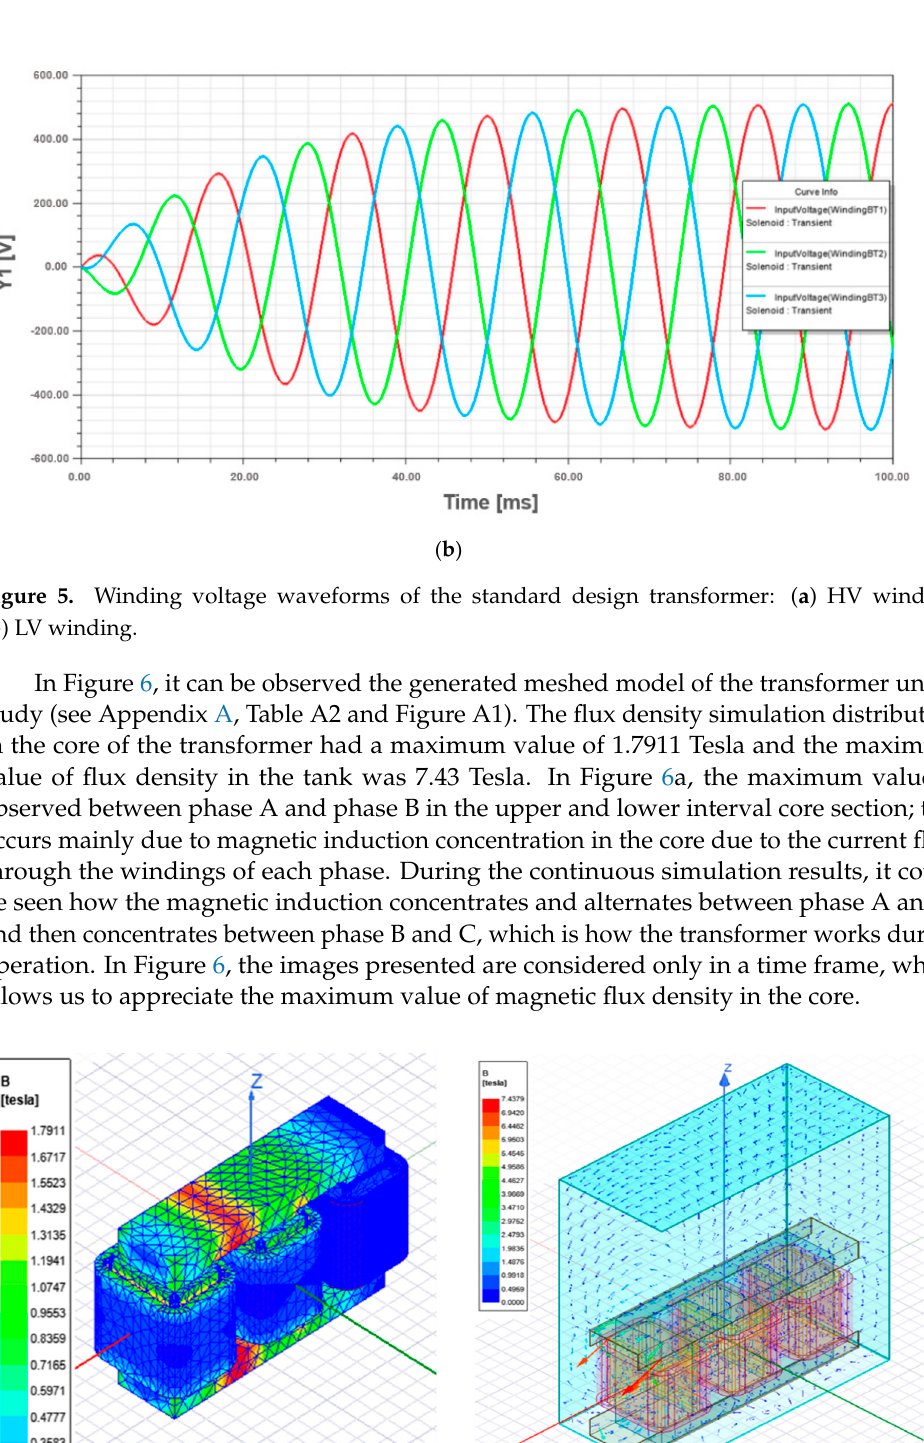
Figure 7. Core losses of standard design transformer. 3.1.5. Simulation Result for Harmonic Profile Design In this section, the simulation was performed using the harmonic profile design data parameters obtained from the manufacturer design system software in Section 3. In Figure 8, the winding excitation voltage results from the simulation are presented, where the maximum peak value for HV winding is 36.25 kV and for LV winding is 512 V. These results are adequate because they present a similar percentage increase according to the previous calculation in the design system manufacturer’s tool.